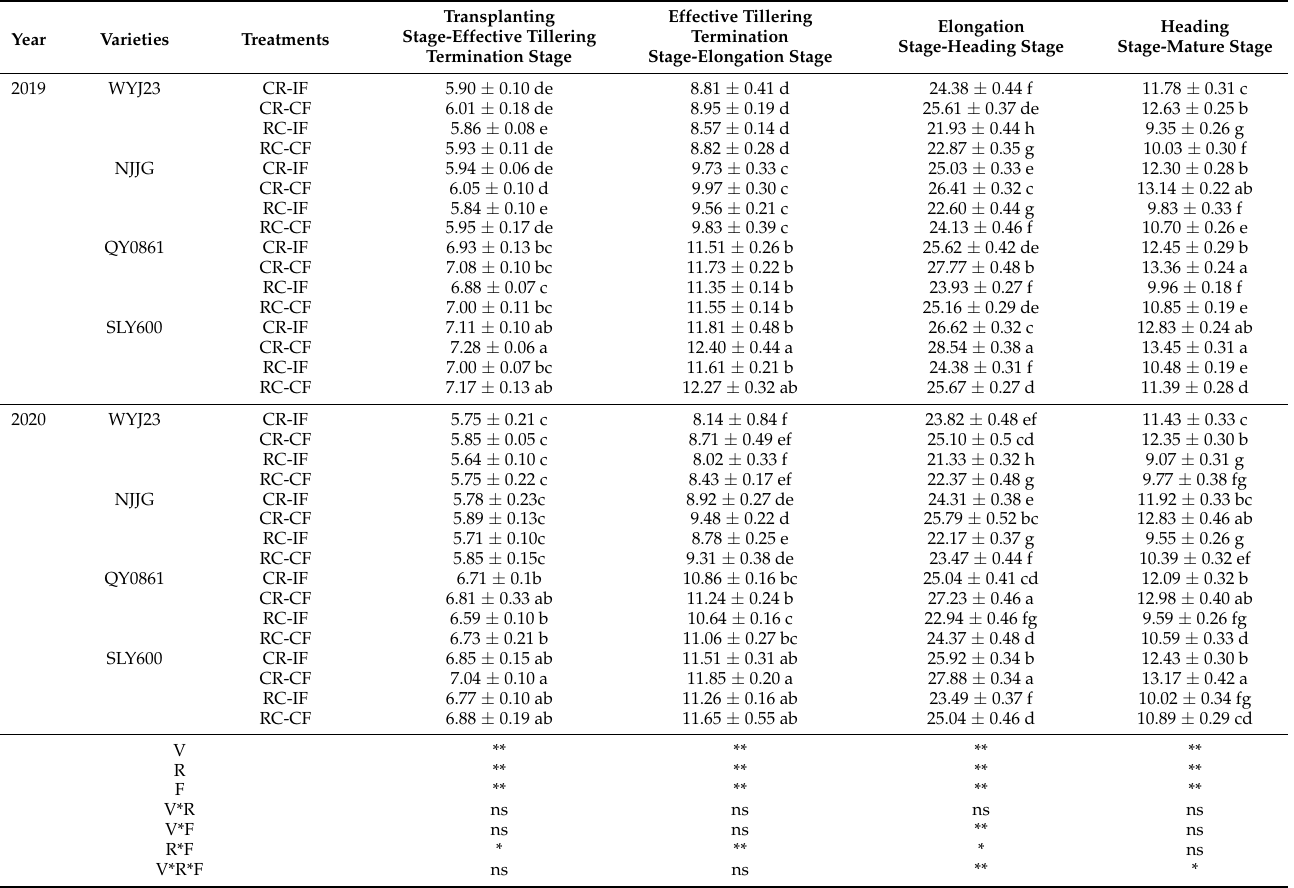
Table 4. Crop growth rate of different rice varieties under two types of fertilizer treatments (Unit: g · m − 2 · d − 1